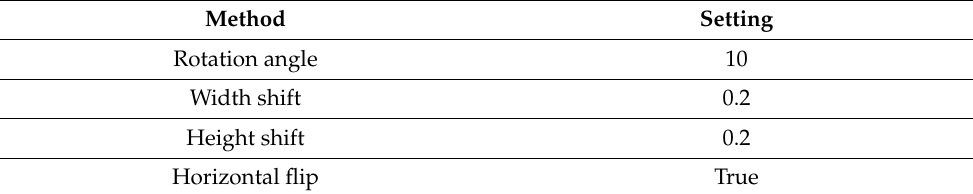
Table 1. Image augmentation settings.